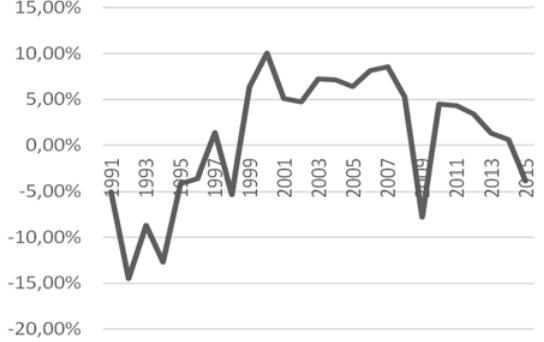
Fig. 1. The rates of GDP growth in Russia (1991-2015), % Source: Federal State Statistics Service of